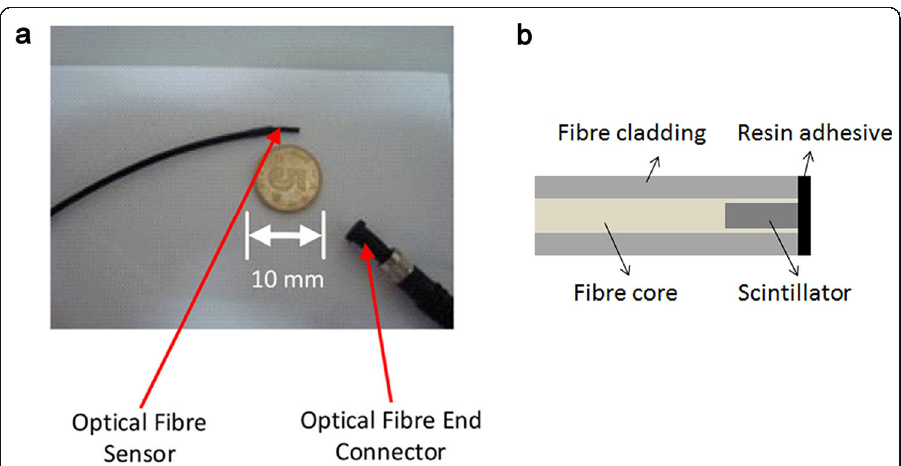
Fig. 6 Embedded structure of an IOSFD. a The IOSFD (photograph) presented by O ’ Keeffe et al. [53]. b The IOSFD (schematic